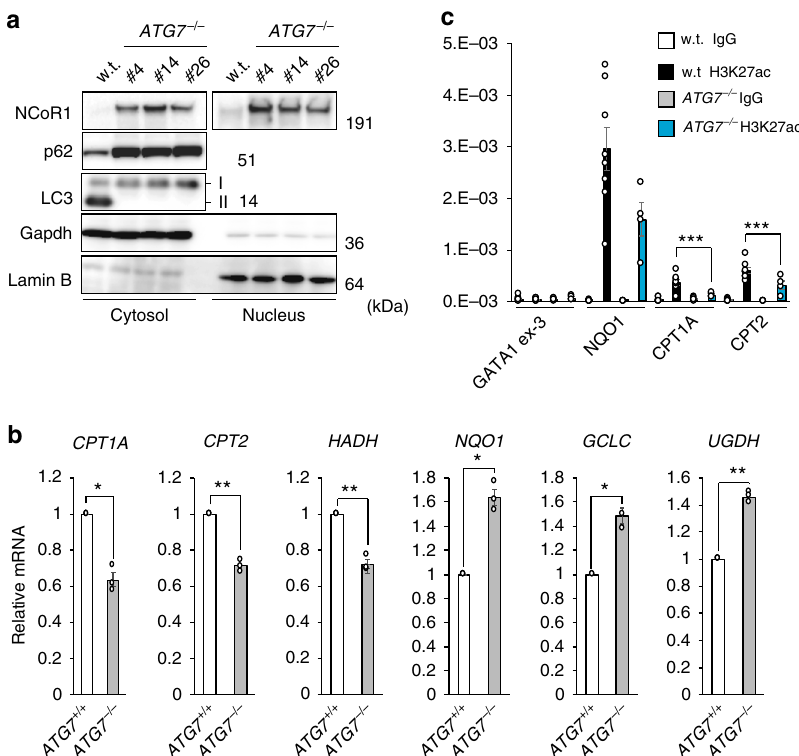
Fig. 3 Decreased H3K27ac deposition on promoter regions of PPAR α targets in autophagy-incompetent cells. a Immunoblot analysis. Both nuclear and cytoplasmic fractions were prepared from three independent ATG7 -knockout HepG2 cells and subjected to immunoblotting with the indicated antibodies. Data are representative of three separate experiments. b Real-time PCR analysis. Total RNAs were prepared from parental HepG2 and ATG7 -de fi cient HepG2 (#14) cells. Values were normalized against the amount of mRNA in parental HepG2 cells. The experiments were performed three times. c H3K27ac deposition was compared between wild-type and ATG7 - knockout HepG2 cells (#4) by ChIP assay at indicated genomic regions. GATA1 -ex3 and NQO1 promoter regions were used as negative and positive controls, respectively. Data are average ± s.e.m. from four independent experiments. Statistical analysis was performed by Welch ’ s t -test. * P < 0.05, and ** P <